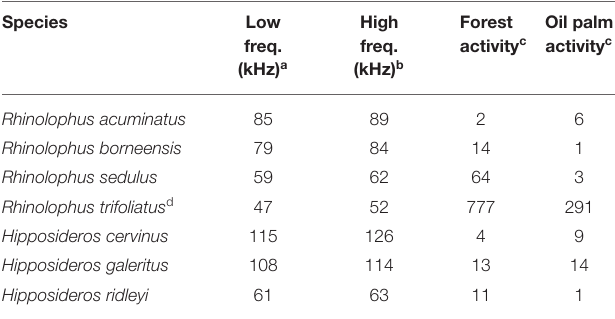
TABLE 2 | Call parameters of constant frequency (CF) bats identified in this study along with their activity in the riparian reserves. Species Low